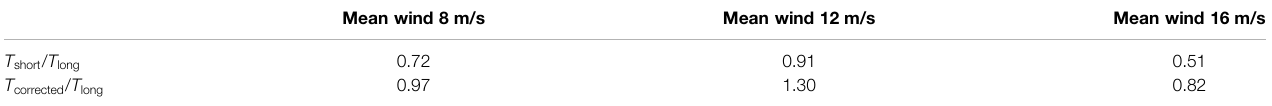
TABLE 4 | Correction results for measured FWT response: 20 h (long) and 2 min (short). Five years return period